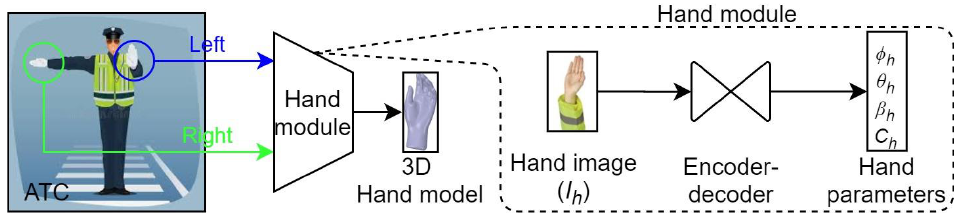
Figure 6. Scheme for 3D hand modeling of the traffic control hand gestures.